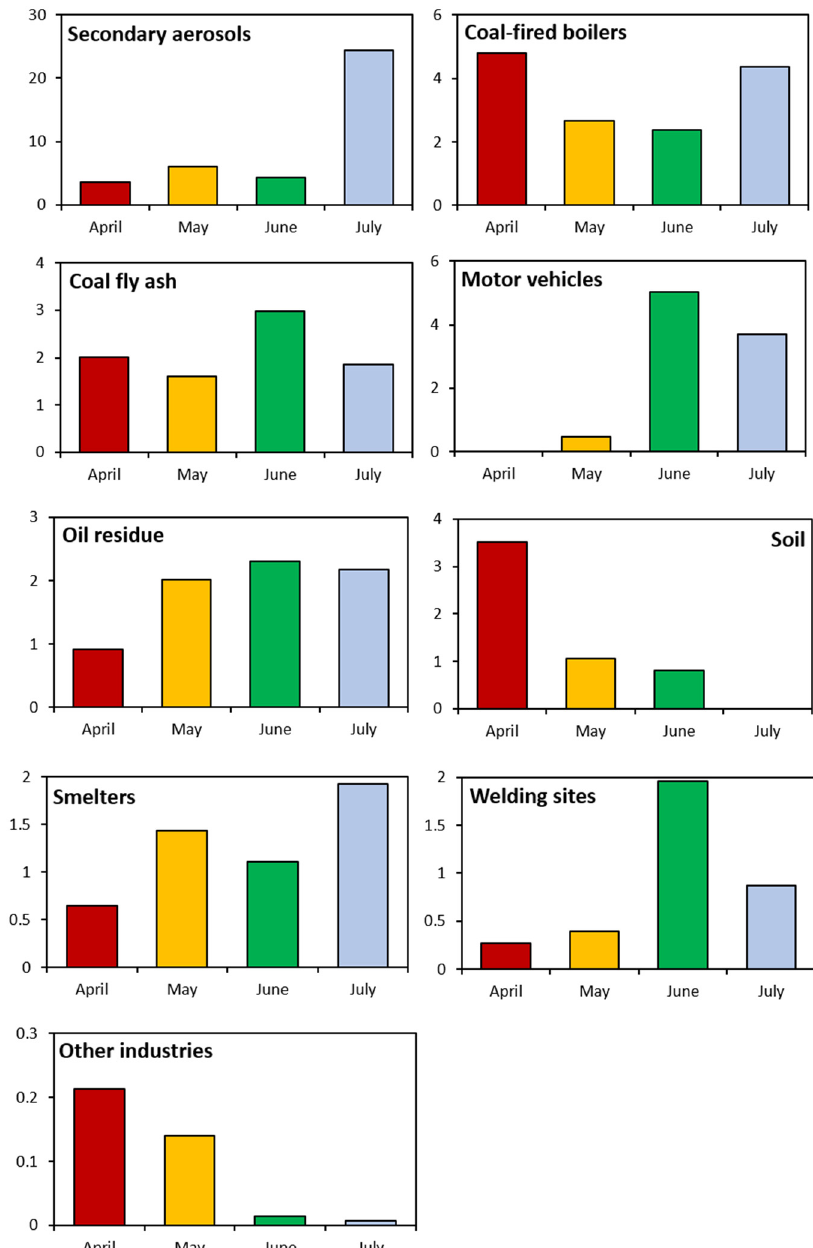
Figure 6. Monthly variation in source contribution to PM 2.5.